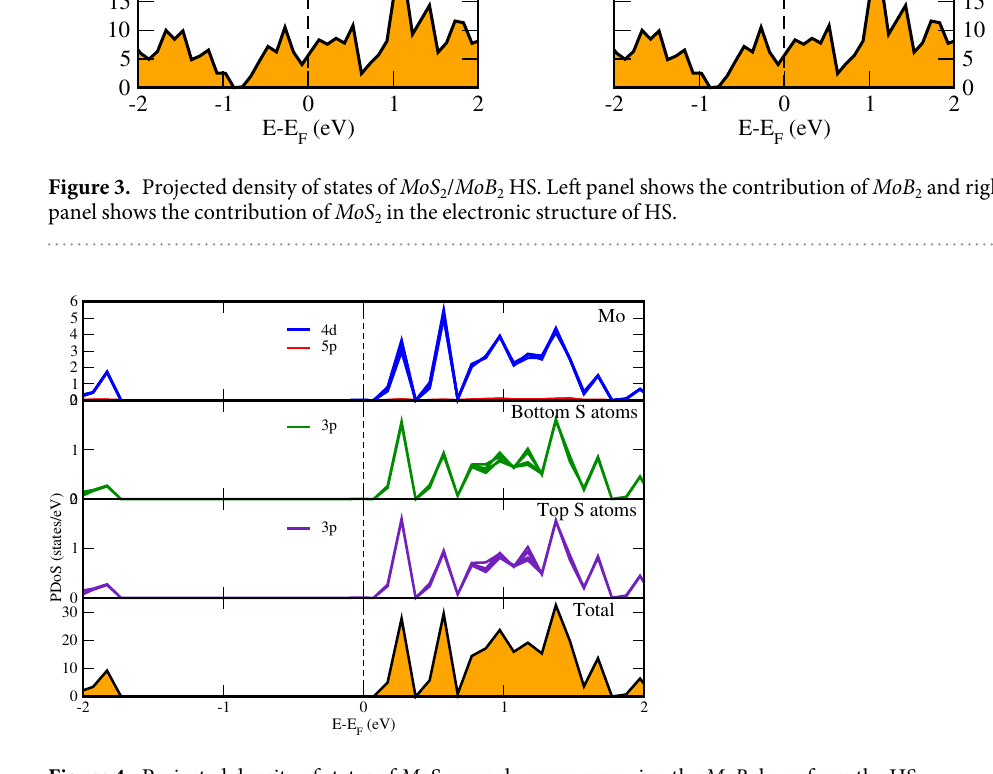
Figure 4. Projected density of states of MoS 2 monolayer on removing the MoB 2 layer from the